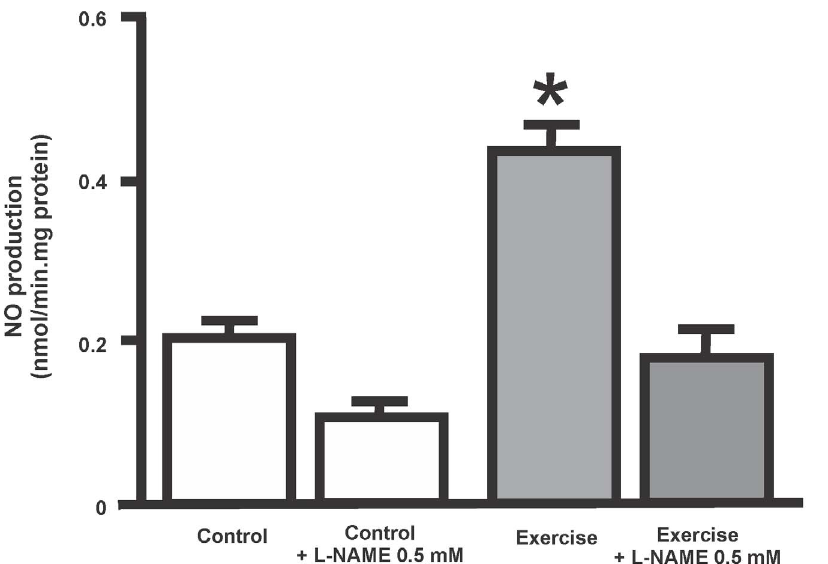
Figure 2. Effects of physical exercise on NO production in cytosolic samples from placental tissue. The specificity of the assay was evaluated using 0.5 mM L-NAME. Data are expressed as mean 6 SEM. (*p , 0.05, as compared with control value).